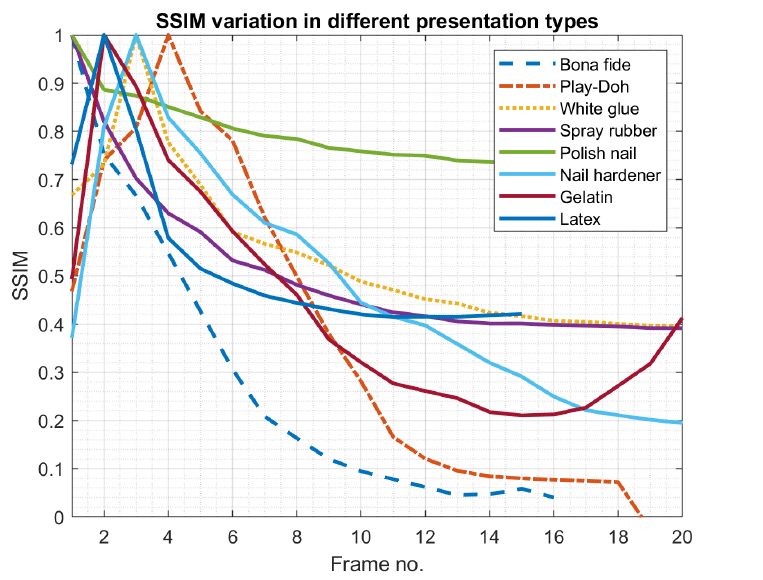
Figure 4. Illustration of ( SSIM ) n for a bona fide and 7 attack presentations. The presentations are m = 1 acquired using the optical